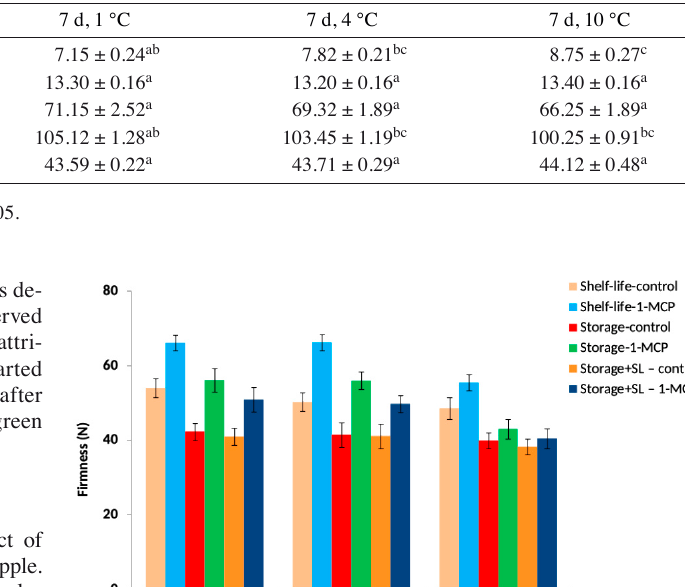
Tab. 1: Quality parameters before and after precooling treatment (mean value ± SD)